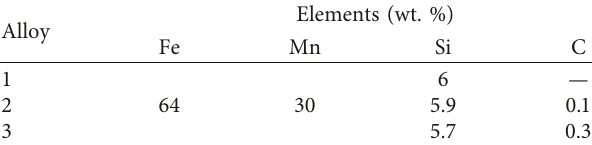
Table 1: Chemical compositions of the alloys.